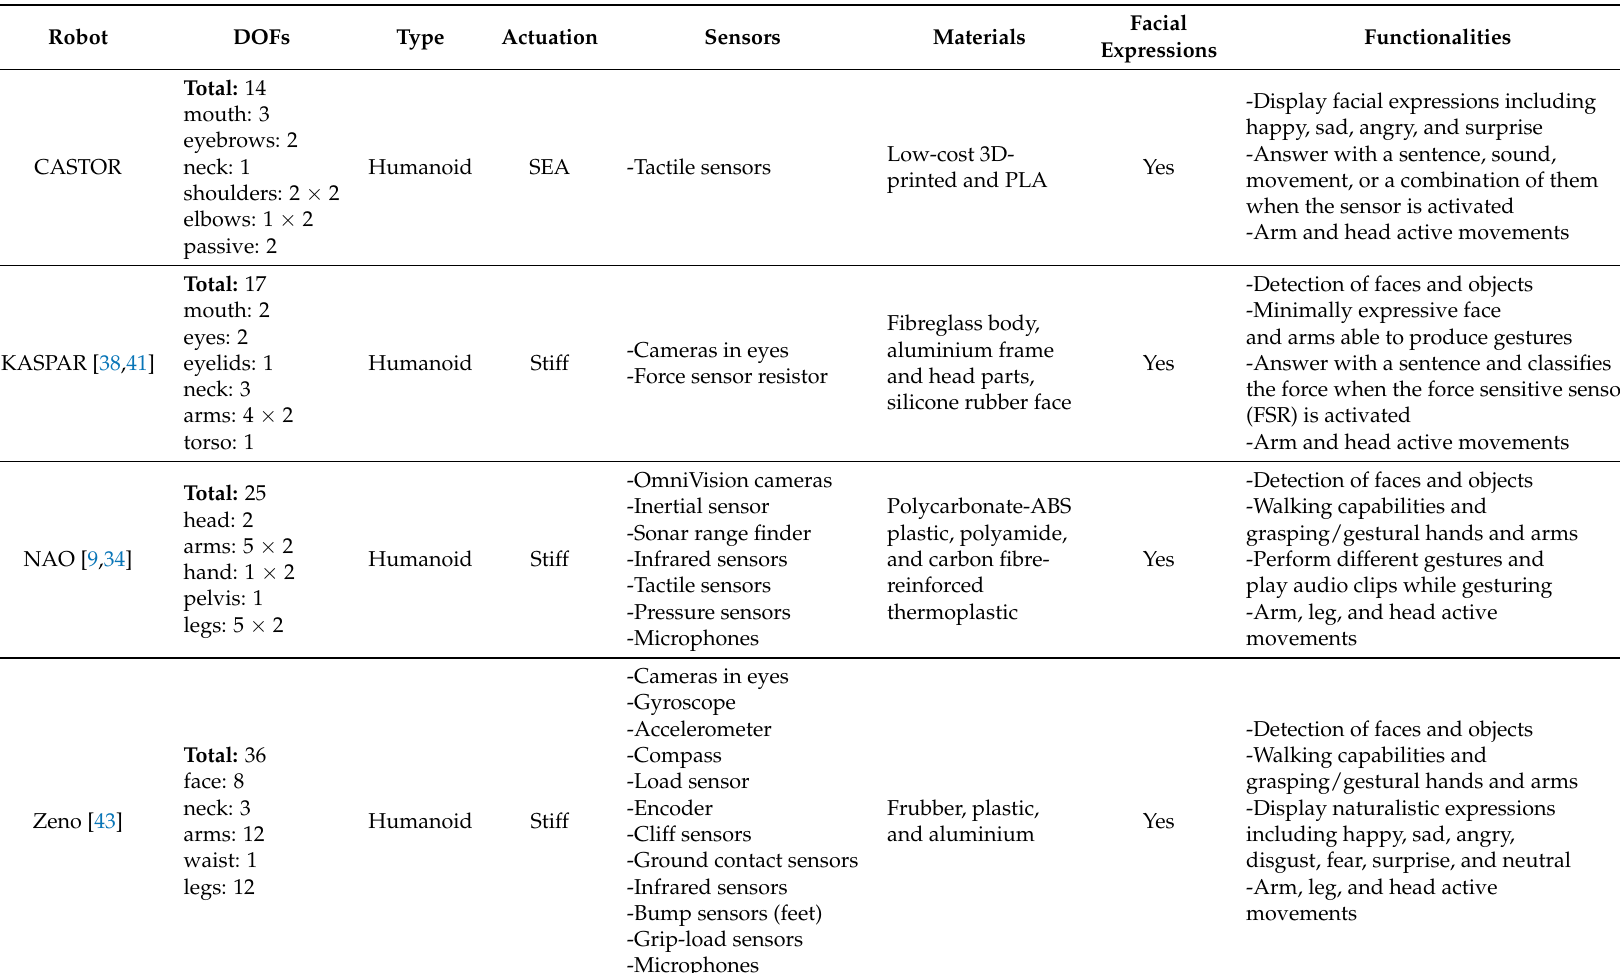
Table 1. Characteristics of robotic platforms aimed at therapy for